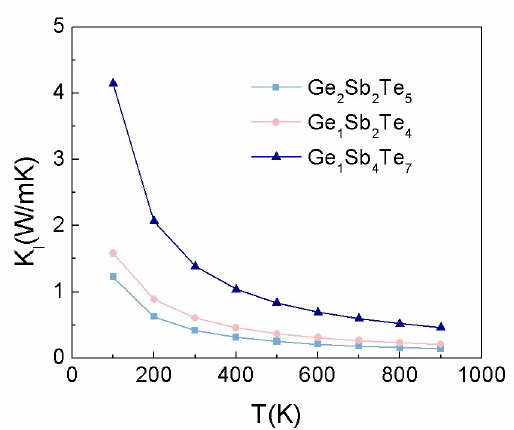
Figure 2. Calculated lattice thermal conductivity of h -GST phase-change materials along the out of plane direction.